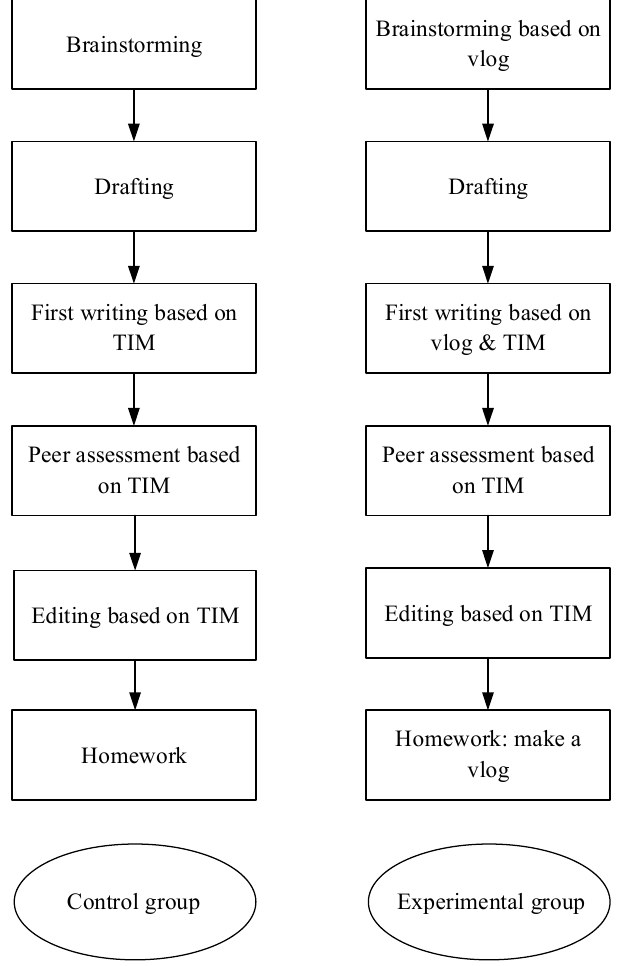
Figure 3. Experimental procedures.